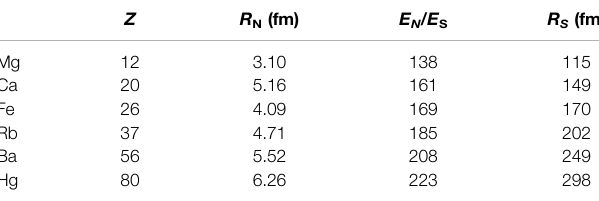
TABLE 1 | Relevant nuclear parameters for bare atomic